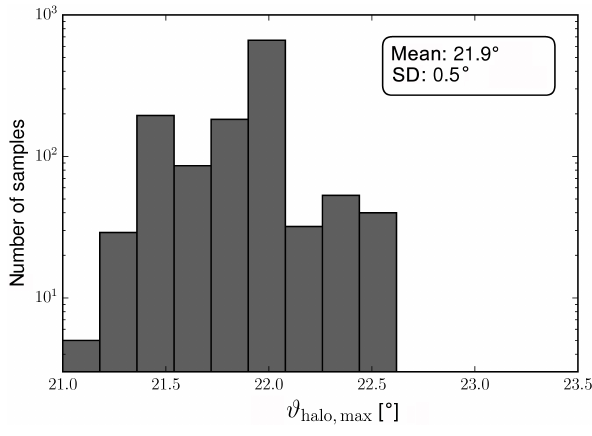
Figure 6. Distribution of the scattering angles of the 22 ◦ halo brightness maximum ϑ halo,max in degrees for 1289 randomly cho- sen and visually classified images using the uppermost image seg- ment (no. 4). The mean value amounts to 21.9 ◦ with a 2 σ confi- dence interval of ± 0 . 5 ◦ . Note the logarithmic scale of the y axis.